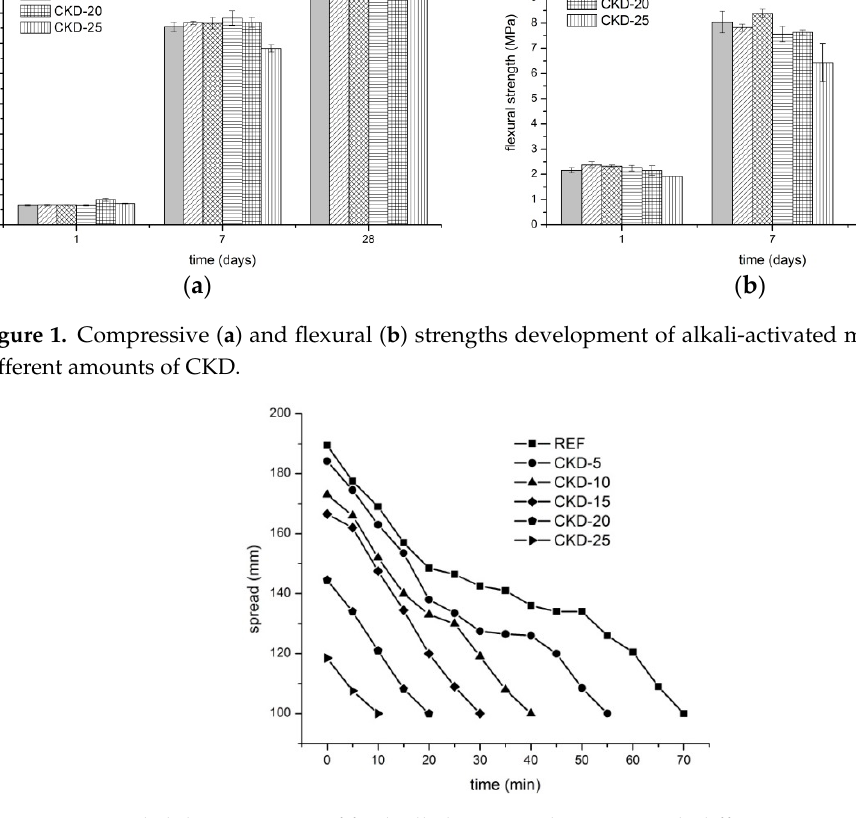
Figure 2. Workability over time of fresh alkali-activated mortars with different amount of CKD.